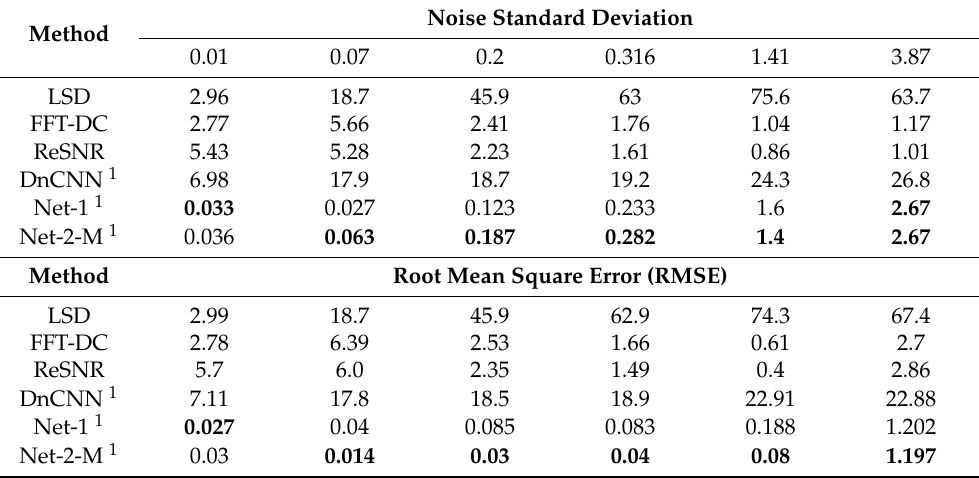
Table 4. The noise estimation results of the references and the proposed model.